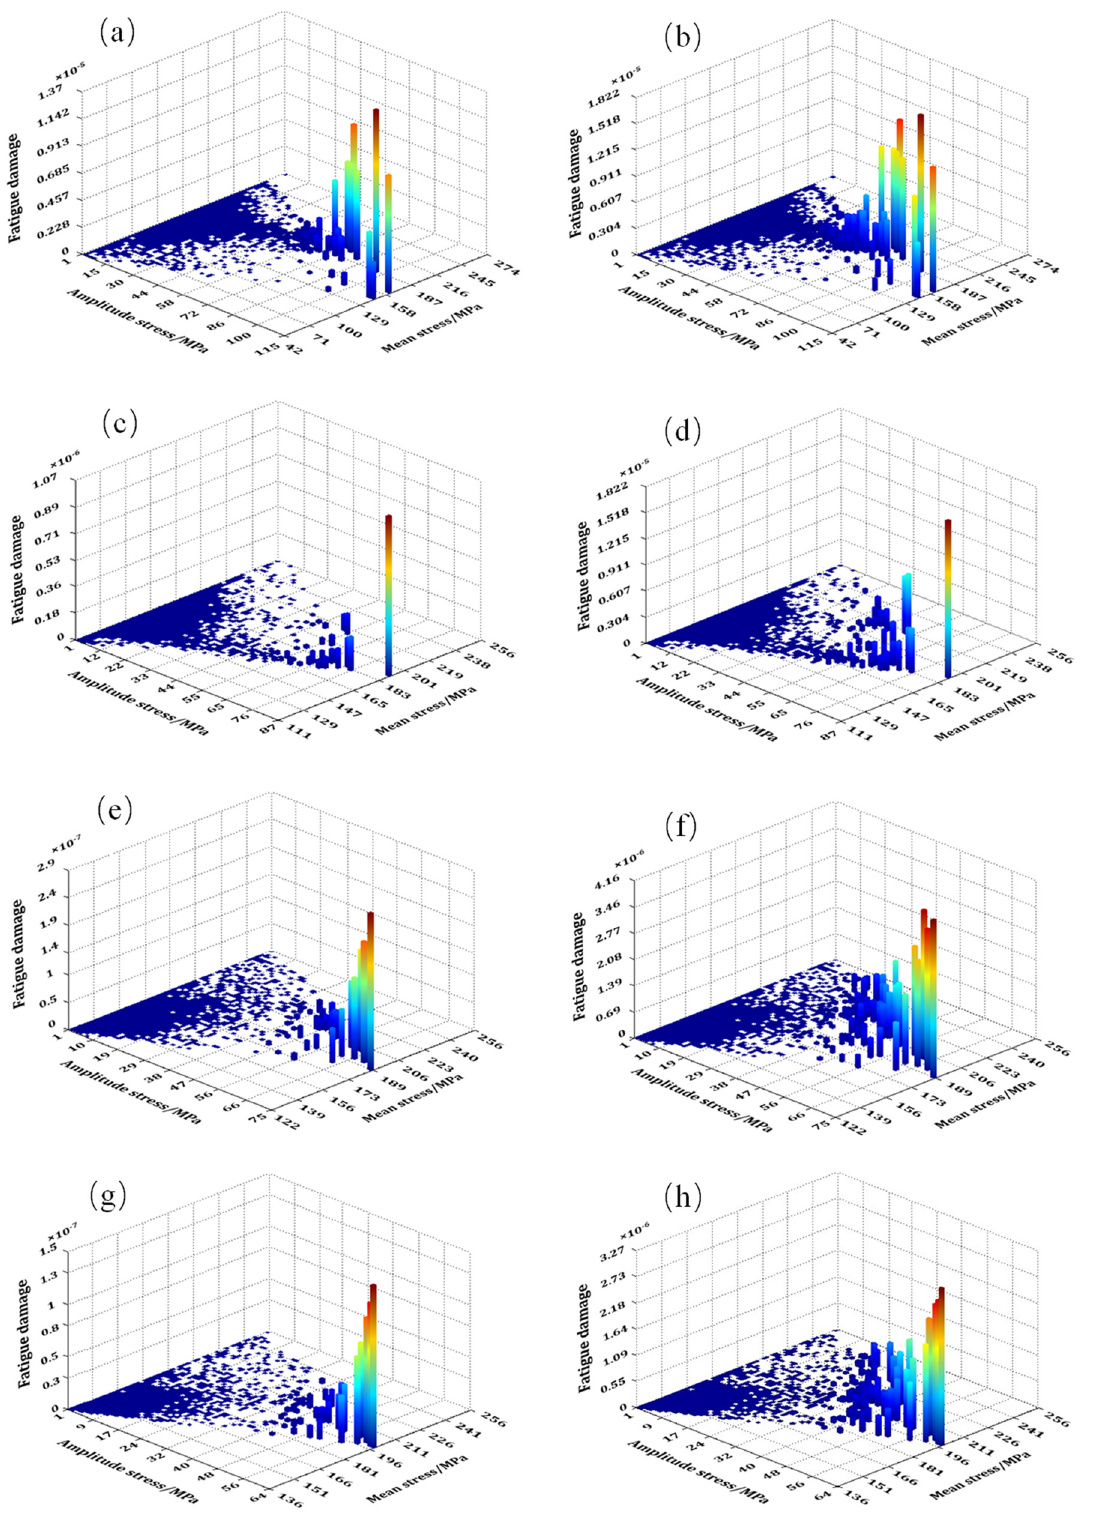
Figure 22: 64 - grade fatigue damage spectra of connection components. ( a ) Contact clamp in 50% SR; ( b ) contact clamp in 99.99% SR; ( c ) messenger clamp in 50% SR; ( d ) messenger clamp in 99.99% SR; ( e ) support base in 50% SR; ( f ) support base in 99.99% SR; ( g ) bushing ears in 50% SR; ( h ) bushing ears in 99.99%